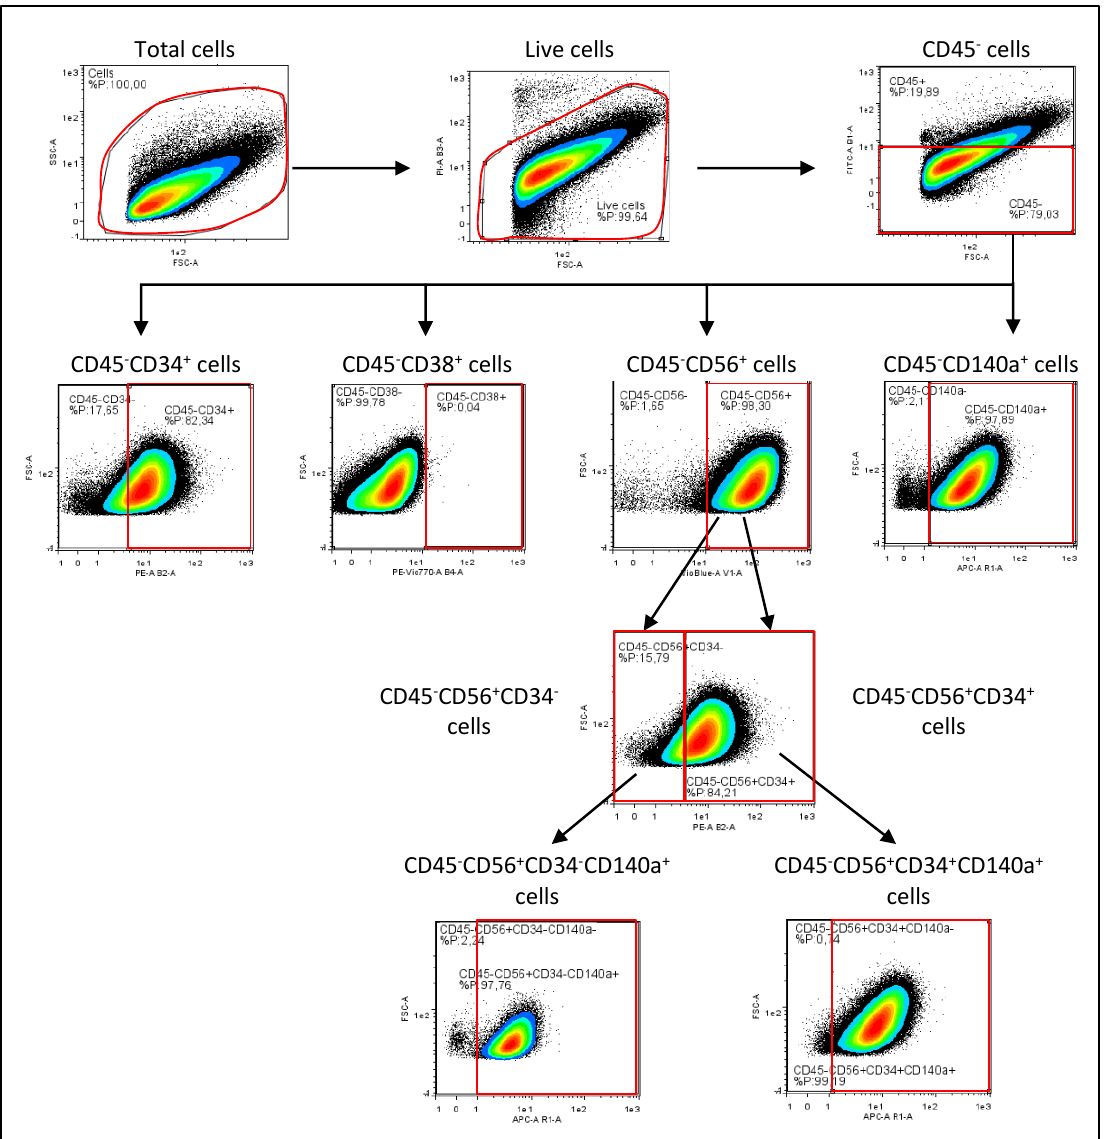
Figure 3. Representative flow cytometry plots illustrating the immunophenotyping strategy used for mesenchymal stromal/stem cells isolated from longissimus muscle tissue of growing pigs. The captions correspond to the cell populations highlighted in red. In addition, the red boxes delimit the positivity threshold of studied cell populations established according to the appropriate isotype and Fluorescence Minus One